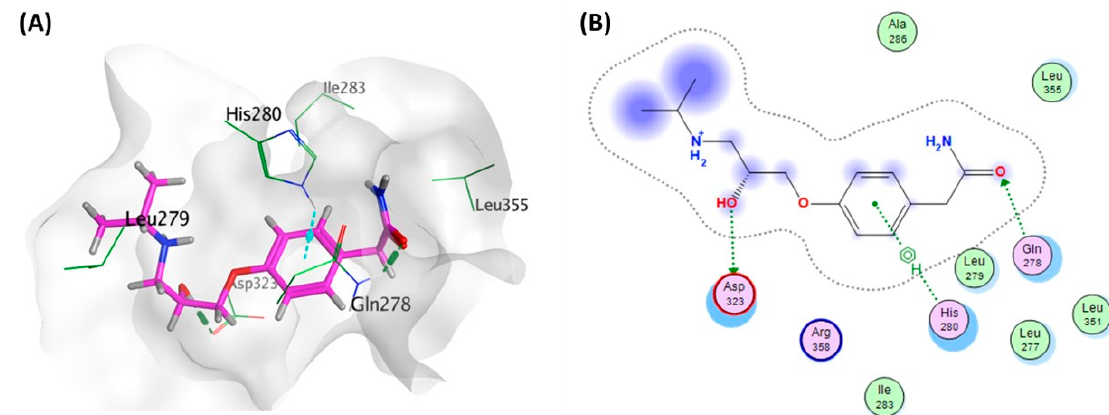
Figure 8. ( A ) 3D Atenolol ‐ E. coli QseC interaction diagram, Atenolol is in thick purple sticks within the molecular surface of the active site, amino acid residues of the active site are shown as thin green sticks. H ‐ bond is presented as green dots and pi ‐ H bond is presented as turquoise bonds. ( B ) 2D Atenolol − E. coli QseC interaction plot.